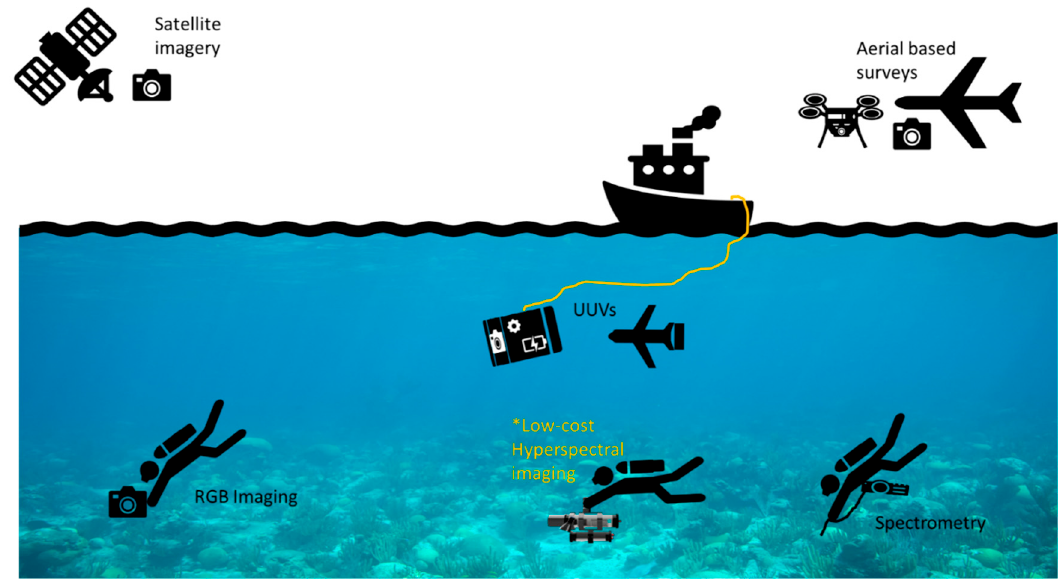
Figure 1. An overview of the current optical techniques from satellites to underwater systems such as unmanned underwater vehicles (UUVs).